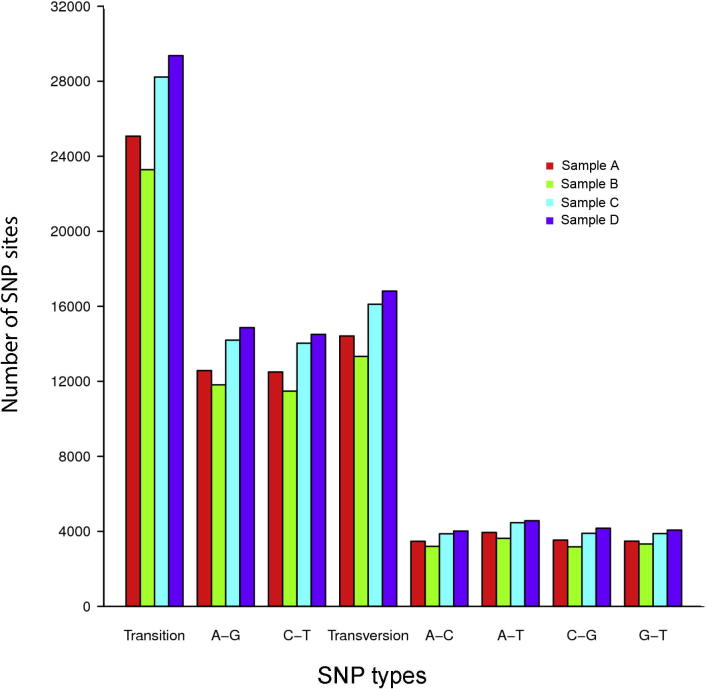
SNP variations found in different B. hookeriana transcriptomic samples